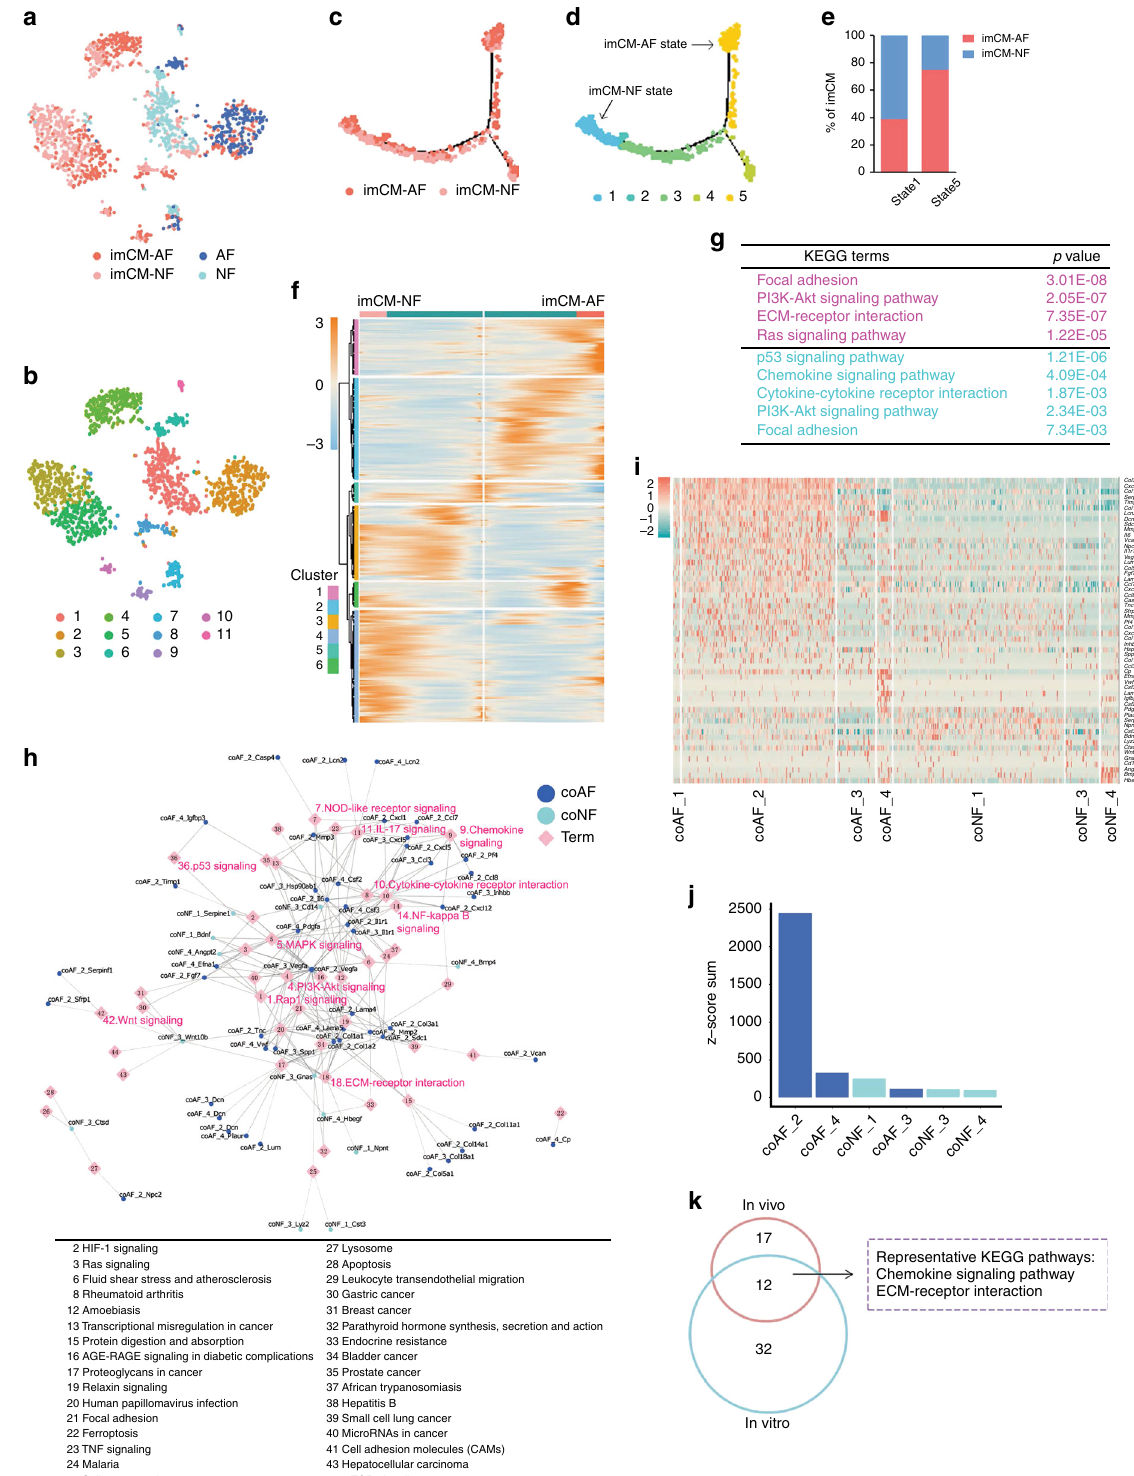
signaling29 Leukocyte transendothelial